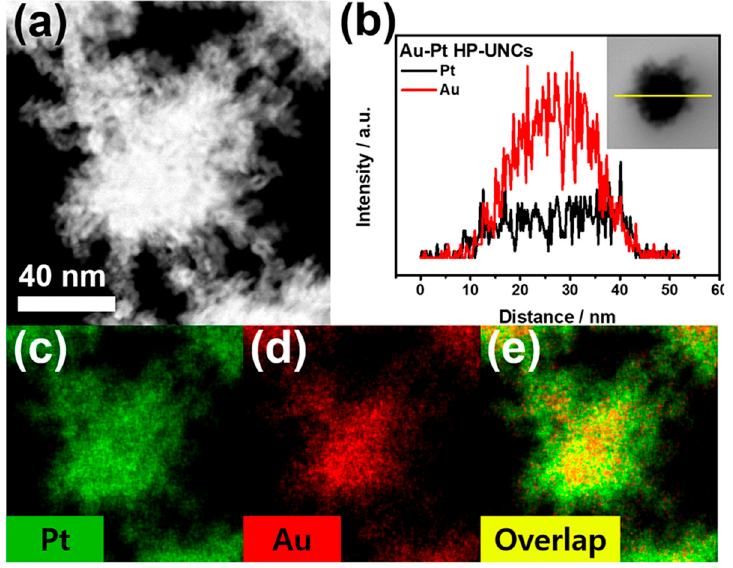
Figure 4. ( a ) HAADF-STEM, ( b ) cross-sectional compositional line profiles, and ( c – e ) HAADF-STEM-EDS elemental mapping images of an Au–Pt HP-UNC.